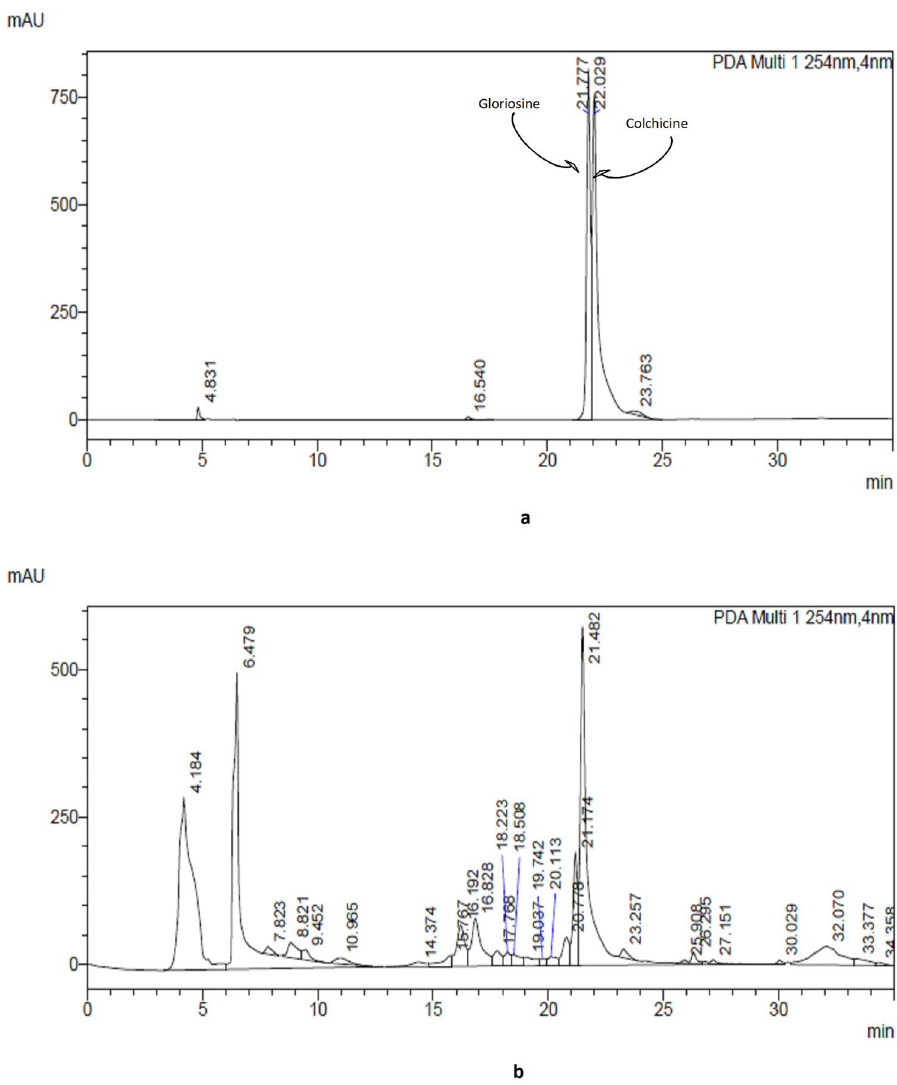
Figure 3. RP-HPLC chromatogram of colchicine and gloriosine. HPLC chromatogram of the standard colchicine and gloriosine ( a ). Identification of colchicine and gloriosine through RP-HPLC in Gloriosa superba extract ( b